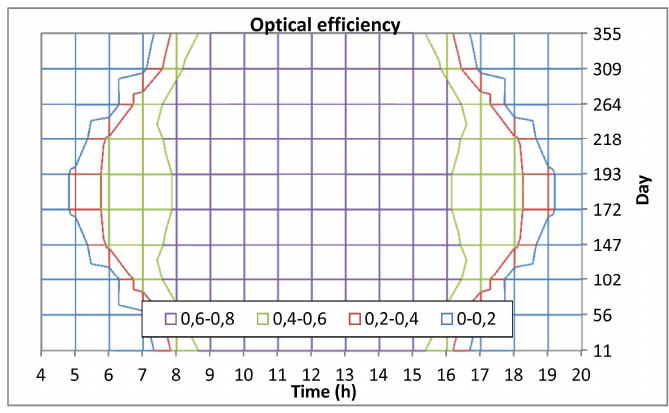
Figure 5. Optical efficiency of the heliostat solar field.